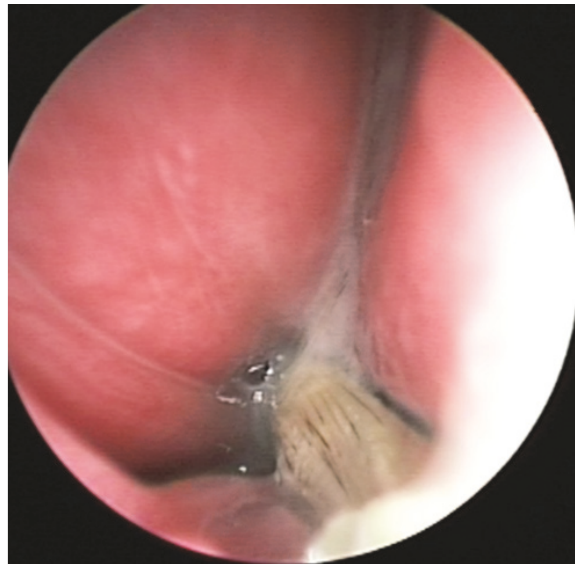
Figure 1: Grass awn in dog nostril during endoscopy extraction.